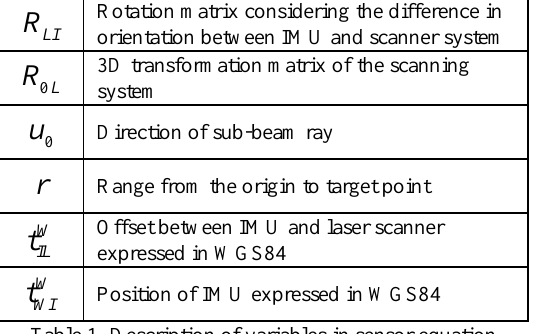
Figure 8. Gaussian beam profile